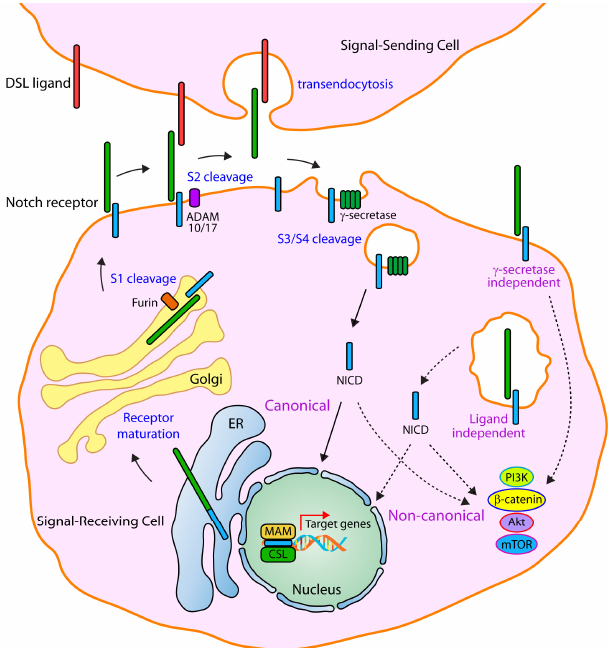
Figure 1. The Notch signaling pathway. Newly synthesized Notch receptors undergo post-translational maturation in the endoplasmic reticulum (ER) and Golgi apparatus. In the ER, Notch receptors are modified by several resident glycosyltransferases that add various O -linked and N -linked glycans in the EGF-repeat region of the Notch extracellular domain. Mature Notch receptors are produced in the Golgi apparatus after their first proteolytical cleavage at the S1 site, whichiscatalyzedbyFurin-likeconvertases, and results in the production of heterodimeric Notch proteins. These heterodimers are thus composed of a ligand-binding Notch extracellular domain (NECD) and a single-pass Notch transmembrane and intracellular domain (NTMICD) that are tethered together through non-covalent and calcium-dependent interactions. The canonical Notch signaling cascade is initiated when Delta / Serrate / Lag-2 (DSL) family ligands present in signal-sending cells bind to the NECD of cognate Notch receptors present in apposed signal-receiving cells. Upon binding, ligand-receptor complexes initiate a transendocytosis process in the signal-sending cell, inducing a biomechanical traction that promotes a conformation change in the receptor, leading to the exposure of the S2 site, on which a proteolytical cleavage is catalyzed by the action of ADAM metalloproteases (ADAM 10 / 17). This ligand-dependent cleavage causes the release of a S1-S2 peptide from the NTMICD and the dissociation of the heterodimeric complex, resulting in the generation of a transient intermediate monomer in the signal-receiving cell called Notch extracellular truncation (NEXT). The S2 cleavage acts as a rate-limiting step during the initiation of the signaling cascade, and it is immediately followed by γ -secretase-mediated cleavages at the S3 and / or S4 sites. The S3 / S4 intramembranous cleavage results in the release of a Notch β fragment (N β -peptide, sequence between S2 and S3 / S4 cleavage sites) to the extracellular (or endosomal) space, and the Notch intracellular domain (NICD) into the cytoplasm of the signal-receiving cell. The released NICD then initiates a translocation journey to the nucleus, where it participates, along with the DNA-binding protein CSL (CBF1 / RBPj κ / Su(H) / Lag-1), Mastermind (MAM)-like proteins and other co-activators, in the formation of transcriptional complexes that initiate the expression of Notch downstream e ff ectors of the Hes and Hey transcription repressor families. In its most generic form, non-canonical Notch signaling (dotted arrows) is independent of CSL and, instead, mediated through interaction with other signaling axes including PI3K, mTOR, Wnt and Akt; and could be triggered through either ligand-dependent or ligand-independent mechanisms, and could also occur in γ -secretase-dependent as well as in γ -secretase-independent modes. Notably, ligand-independent activation of Notch receptors, which mainly occurs in endosomal tra ffi cking routes and multivesicular bodies (MVB), results in the production of NICD, which in-turn could prompt either CSL-dependent as well as CSL-independent signaling